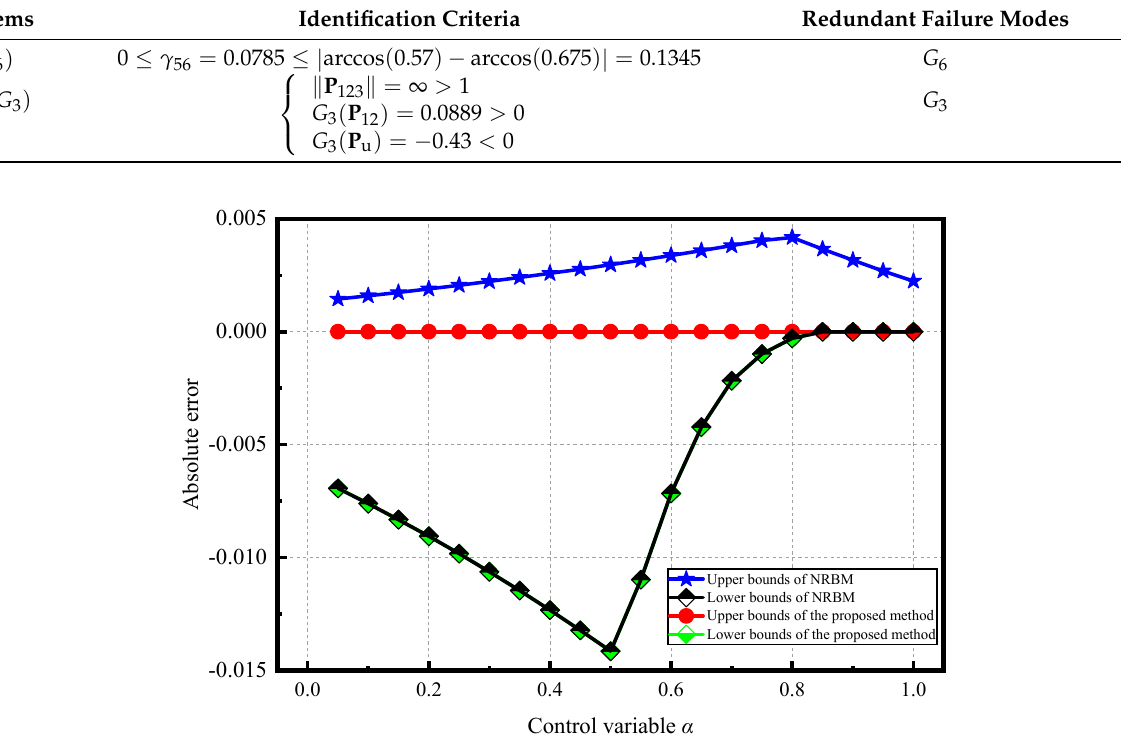
α for numerical example 1.